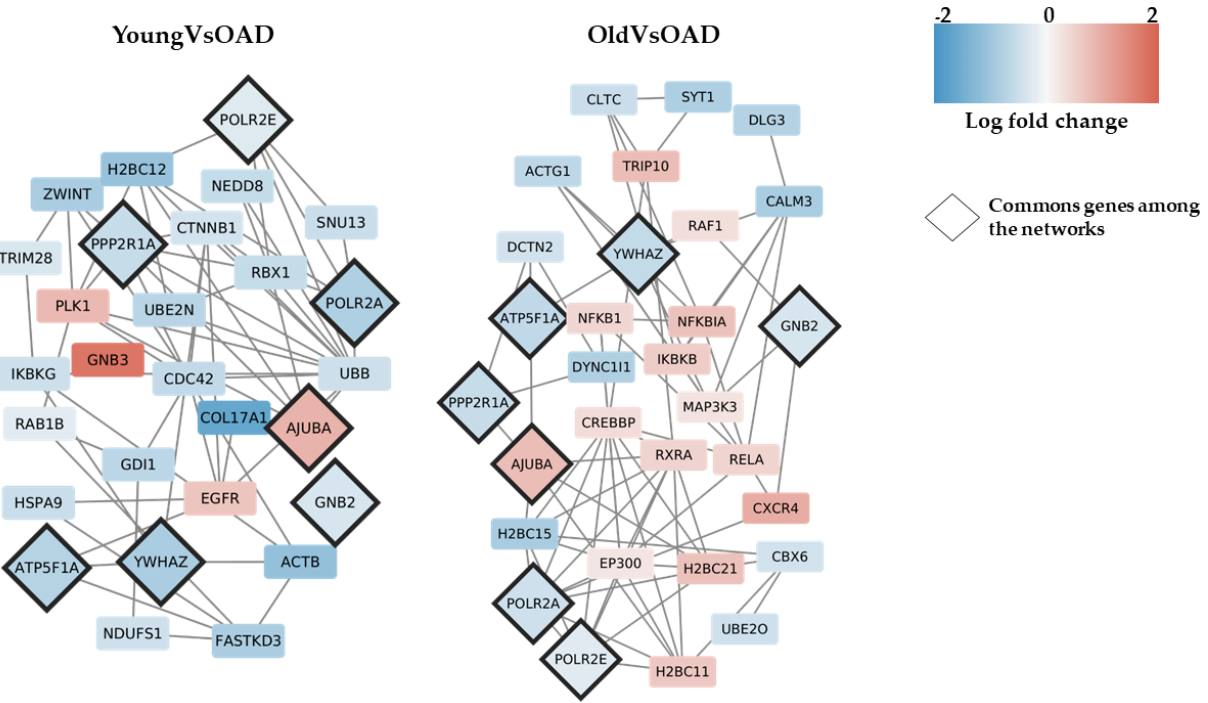
Figure 2. The network analysis of DEGs with the highest betweenness centrality. 29 and 30 are the DEGs with the highest betweenness centrality, respectively, in YoungVsOAD and OldVsOAD. Blue represents the downregulated DEGs and red represents the upregulated DEGs. The seven DEGs common to both networks are represented as rhombus. Table 3. DEGs with betweenness centrality outside the 97.5% distribution in both